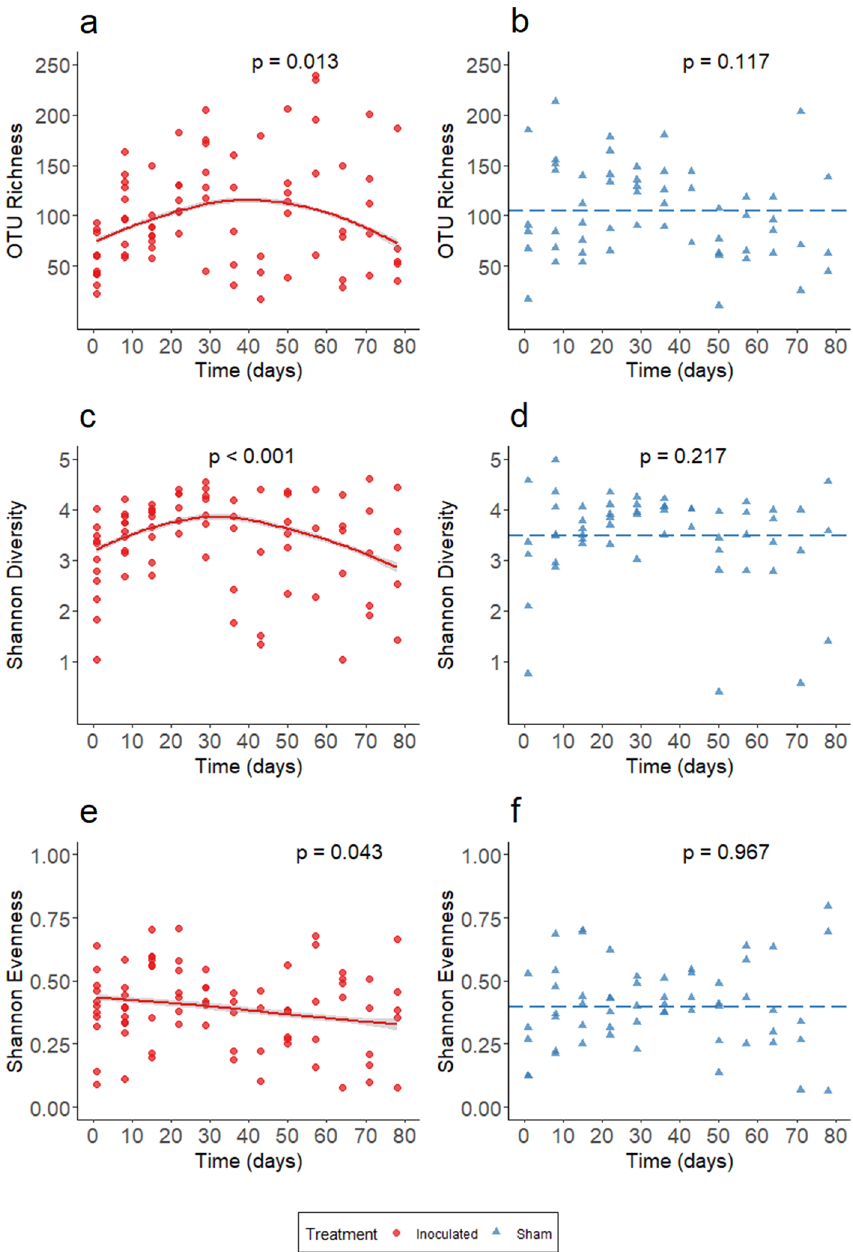
Figure 2. Time is predictive of OTU richness, Shannon diversity, and Shannon Evenness in inoculated but not sham snakes. ( a , b ) OTU richness of the host microbiome as a function of time. ( c , d ) Shannon diversity of the host microbiome as a function of time. ( e , f ) Shannon evenness of the host microbiome as a function of time. ( a , c , e ) Trendlines were generated using generalized additive mixed effects modeling. ( a , c ) Note that both OTU richness and Shannon diversity initially rose and then declined among the inoculated treatment group. ( e ) Among the inoculated treatment group, we observed a decrease in evenness through experimental time. ( b , d , f ) No significant effect of time was found for any measured component of alpha diversity among the sham control group. The dotted line in these subplots represents the mean value for OTU richness, Shannon diversity, or Shannon Evenness. P -values for temporal effects are provided within each